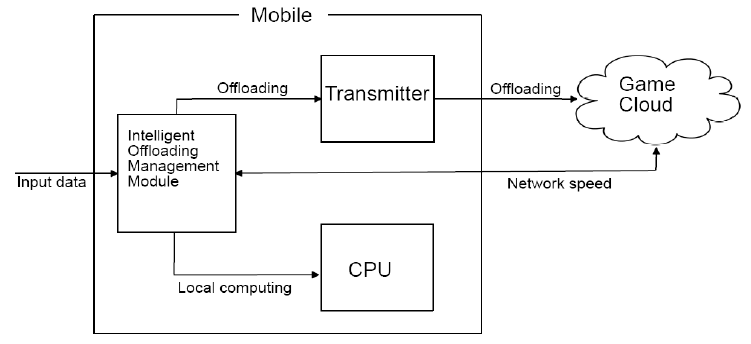
Figure 6. Intelligent offloading management.